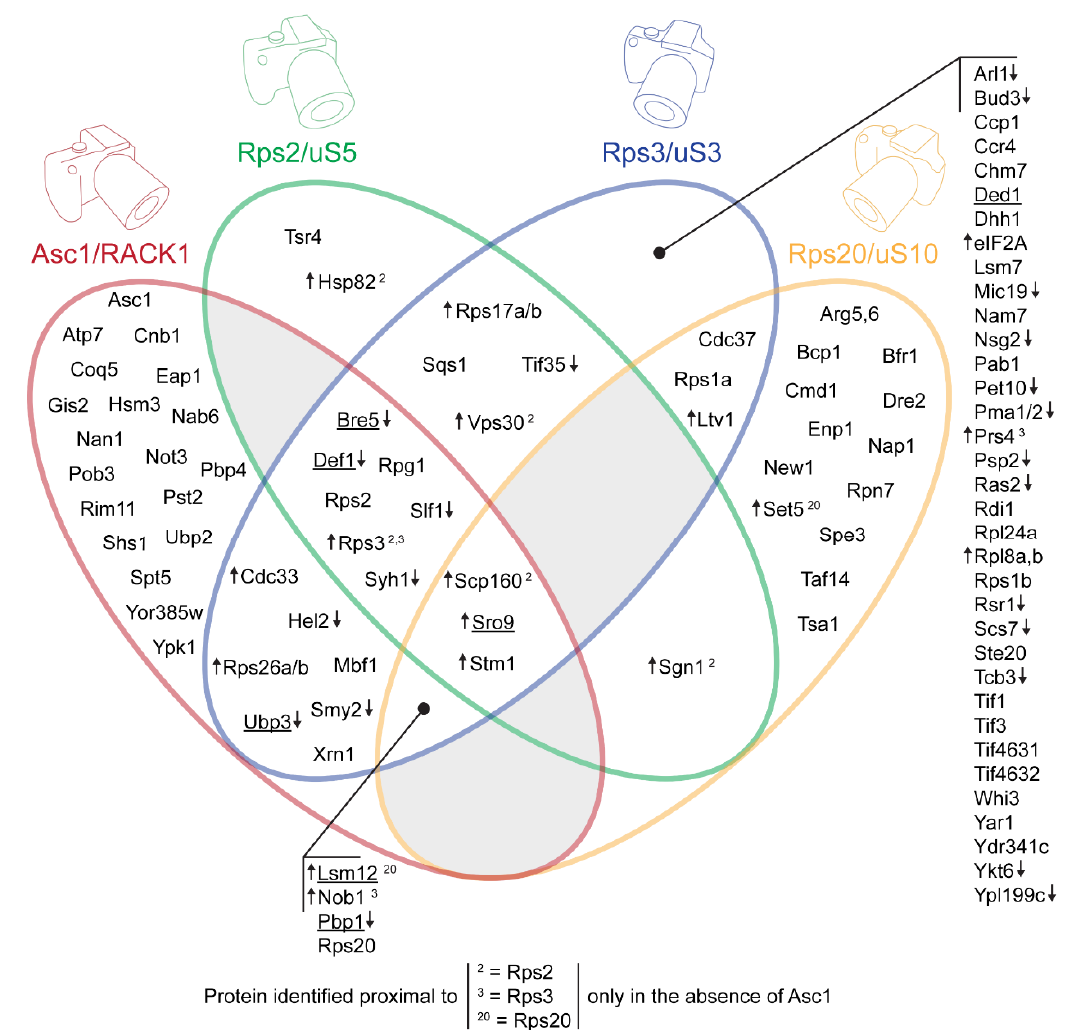
Figure 7. Four adjacent and overlapping perspectives at the hr40S : Comparison of microenvironments captured with Asc1-, Rps2-, Rps3-, and Rps20-BioID. The identified proteins co-localizing with the four different RPs are depicted within a Venn diagram. Proteins that were additionally identified in the common microenvironment of Bre5 and Rps2 with the Bre5- C Tb•Rps2- N Tb Split-TurboID are underlined.